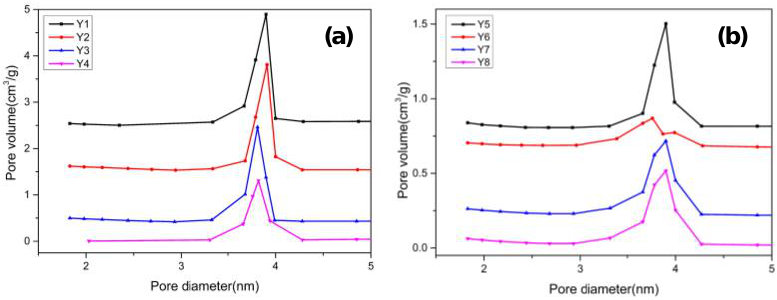
Figure 4. The pore size distribution of zeolites ( a ) Y1 – Y4 and ( b )Y5 – Y8.